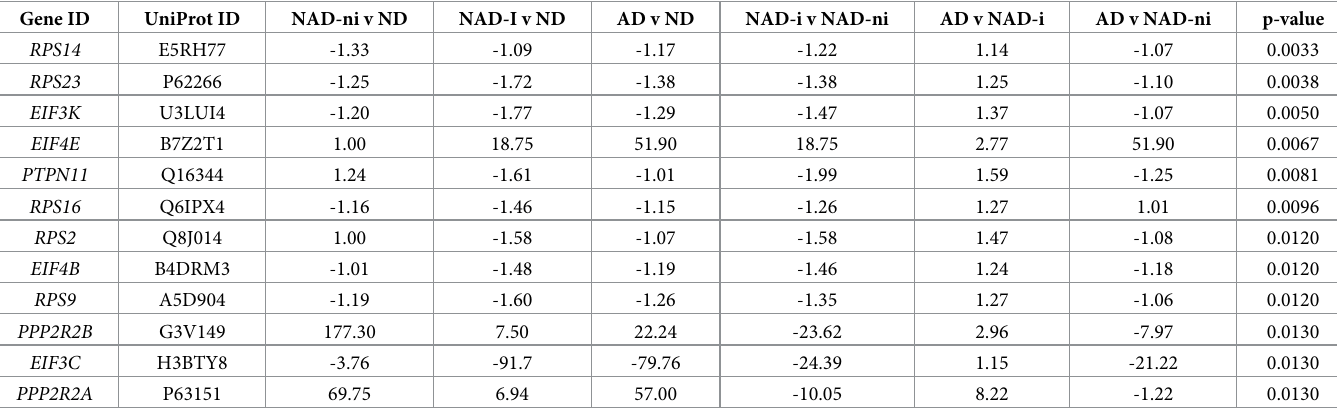
Table 4. Top 12 most significantly altered proteins in T2DM in EDM tissues associated with mTOR signaling. Gene ID UniProt